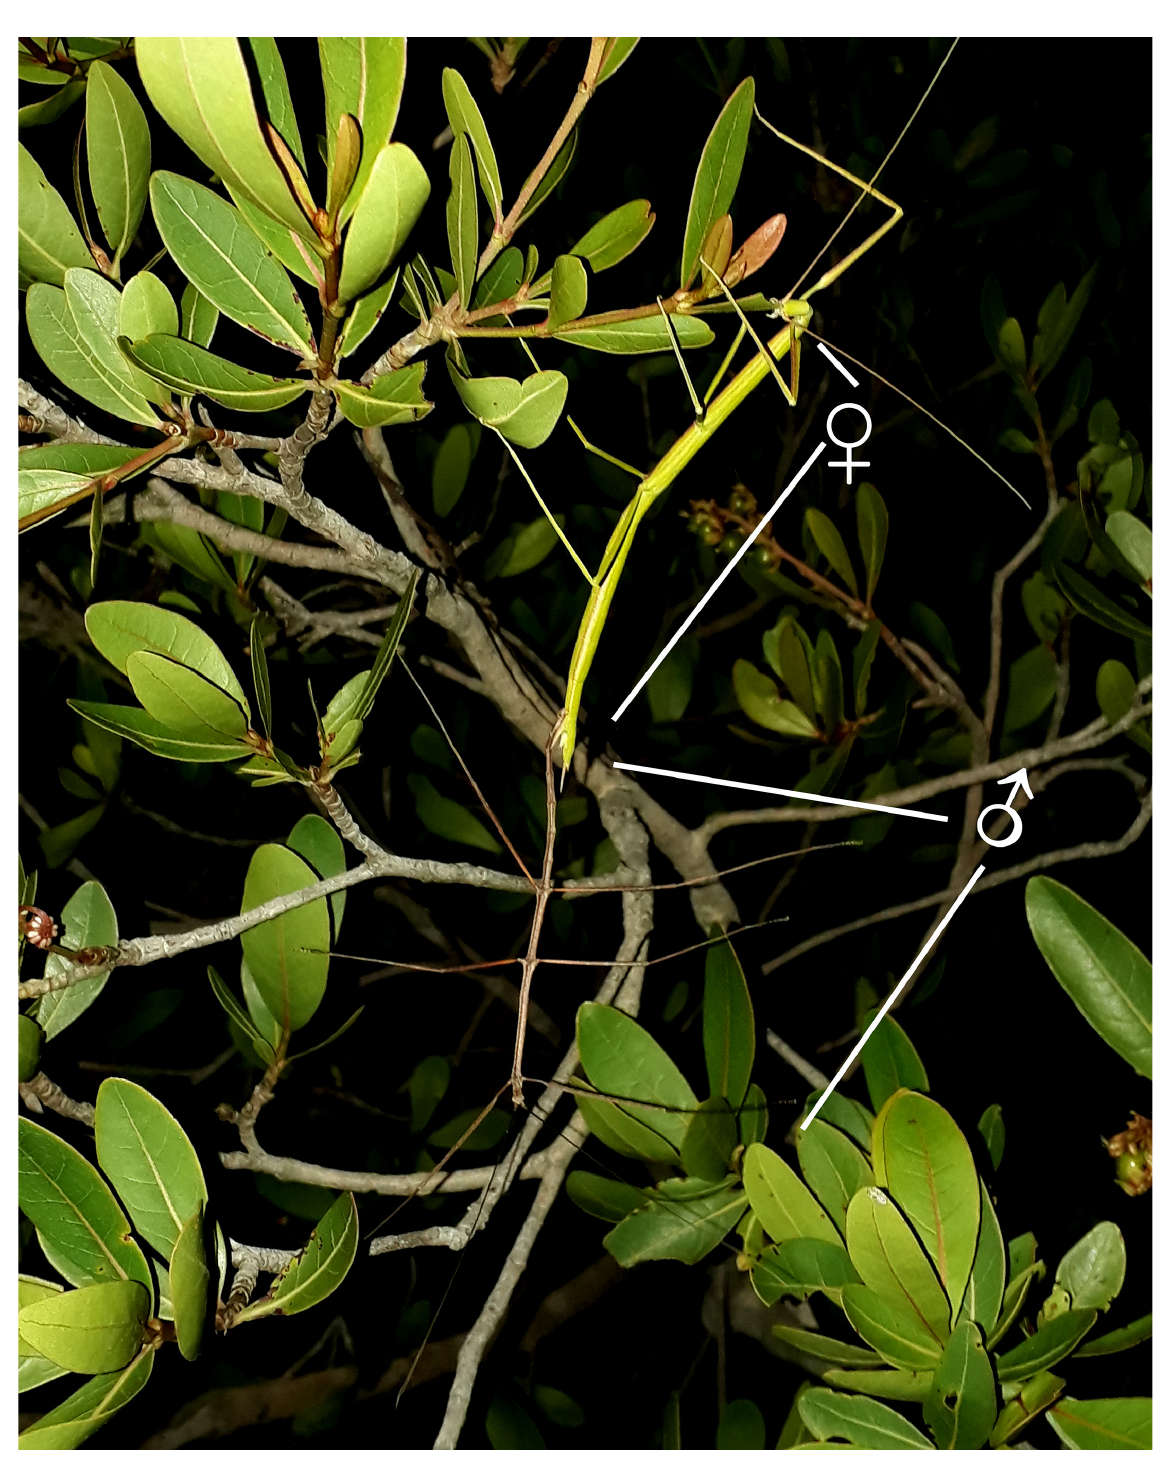
Fig. 44. Arumatia motenata Ghirotto gen. et sp. nov., live habitus in situ at Serra do Cipó, Minas Gerais, Brazil. Adult pair, at night, on locustberry plant ( Byrsonima sp.). Note female feeding on the plant and male hanging attached to the female by the terminalia. Image not to